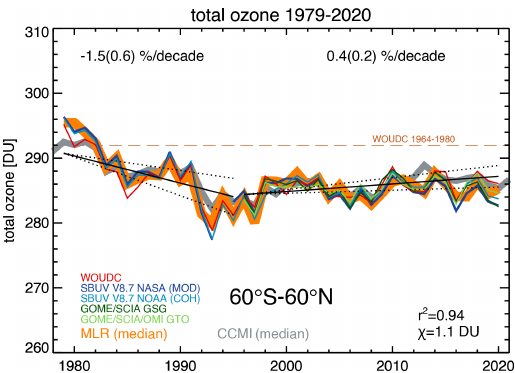
Figure 1. Near-global (60 ◦ S–60 ◦ N) total ozone time series of five bias-corrected merged datasets. The thick orange line is the result from applying the full MLR (Eqs. 1 and 4) to the median time se- ries. The square of the correlation between observations and MLR is given by r 2 . χ 2 is the sum square of the differences between me- dian observational and MLR time series divided by the degrees of freedom (difference between the number of years, n , and number of parameters used in the MLR, m ). The solid lines indicate the lin- ear trends before and after the ODS peak, respectively. The dotted lines indicate the 2 σ uncertainty of the MLR trend estimates. Trend numbers are indicated for the pre- and post-ODS peak period in the top part of the plot. Numbers in parentheses are the 2 σ trend un- certainty. The dashed orange line shows the mean ozone level from 1964 until 1980 from the WOUDC data. The thick grey line is the median of 17 chemistry–climate models from the